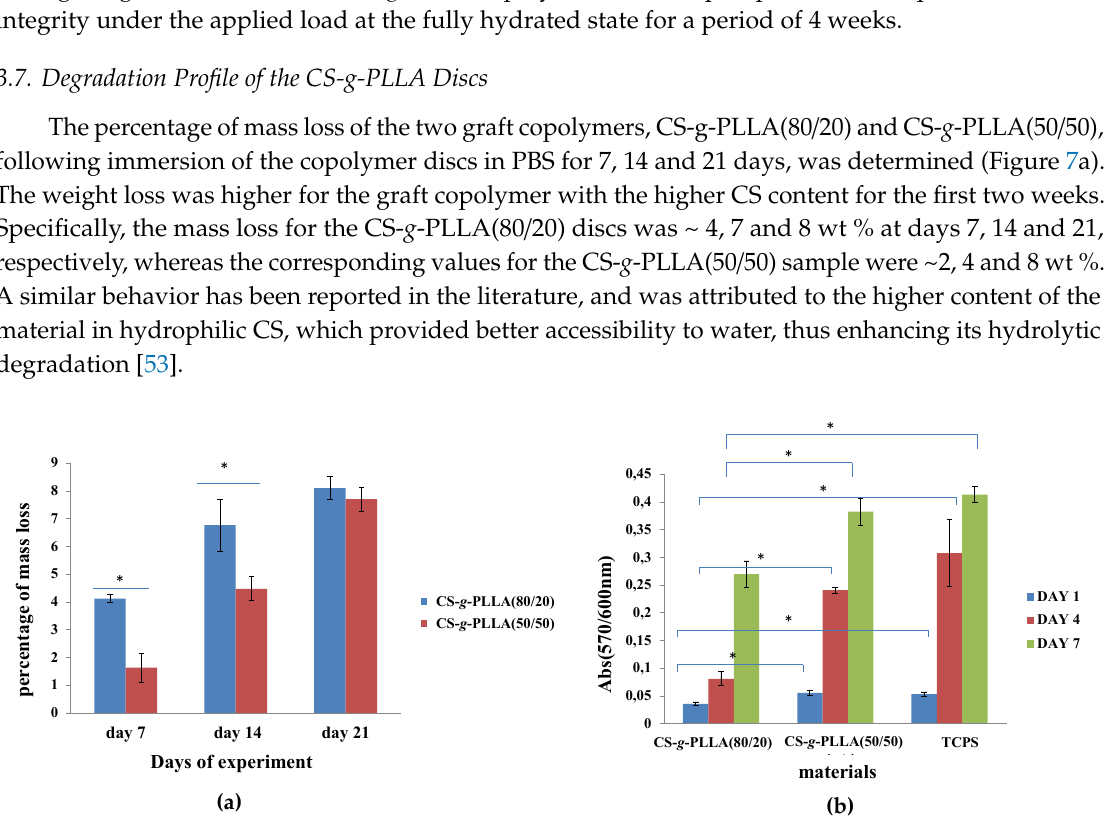
Figure 7. ( a ) Percentage of mass loss for the two graft copolymers, CS- g -PLLA(80/20) and CS- g - PLLA(50/50), following immersion in PBS buffer at 37 °C for 7, 14 and 21 days; ( b ) Cell metabolic activity of pre-osteoblasts cultured on CS- g -PLLA(80/20) and CS- g -PLLA(50/50)) for 1, 4 and 7 days. TCPS was used as a control for the same timepoints. Each bar represents the mean ± standard error of the mean of triplicate wells from two independent experiments.